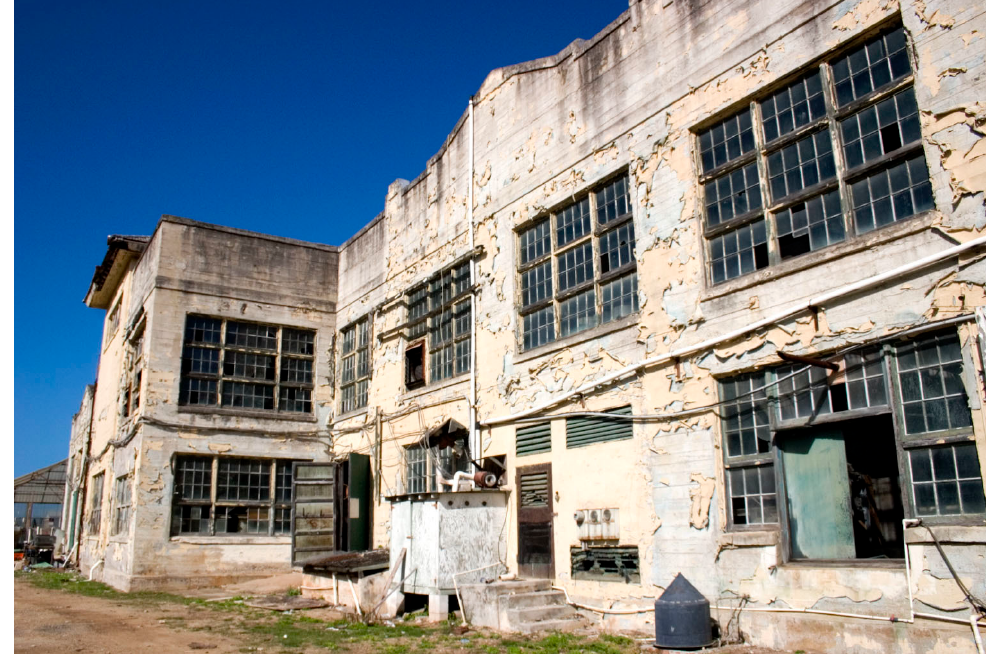
Figure 1.1: Remnants of Marconi facility at Kahuku: views of operational building facade. Image: Jonathan Haeber, Flickr, Creative Commons Attribution